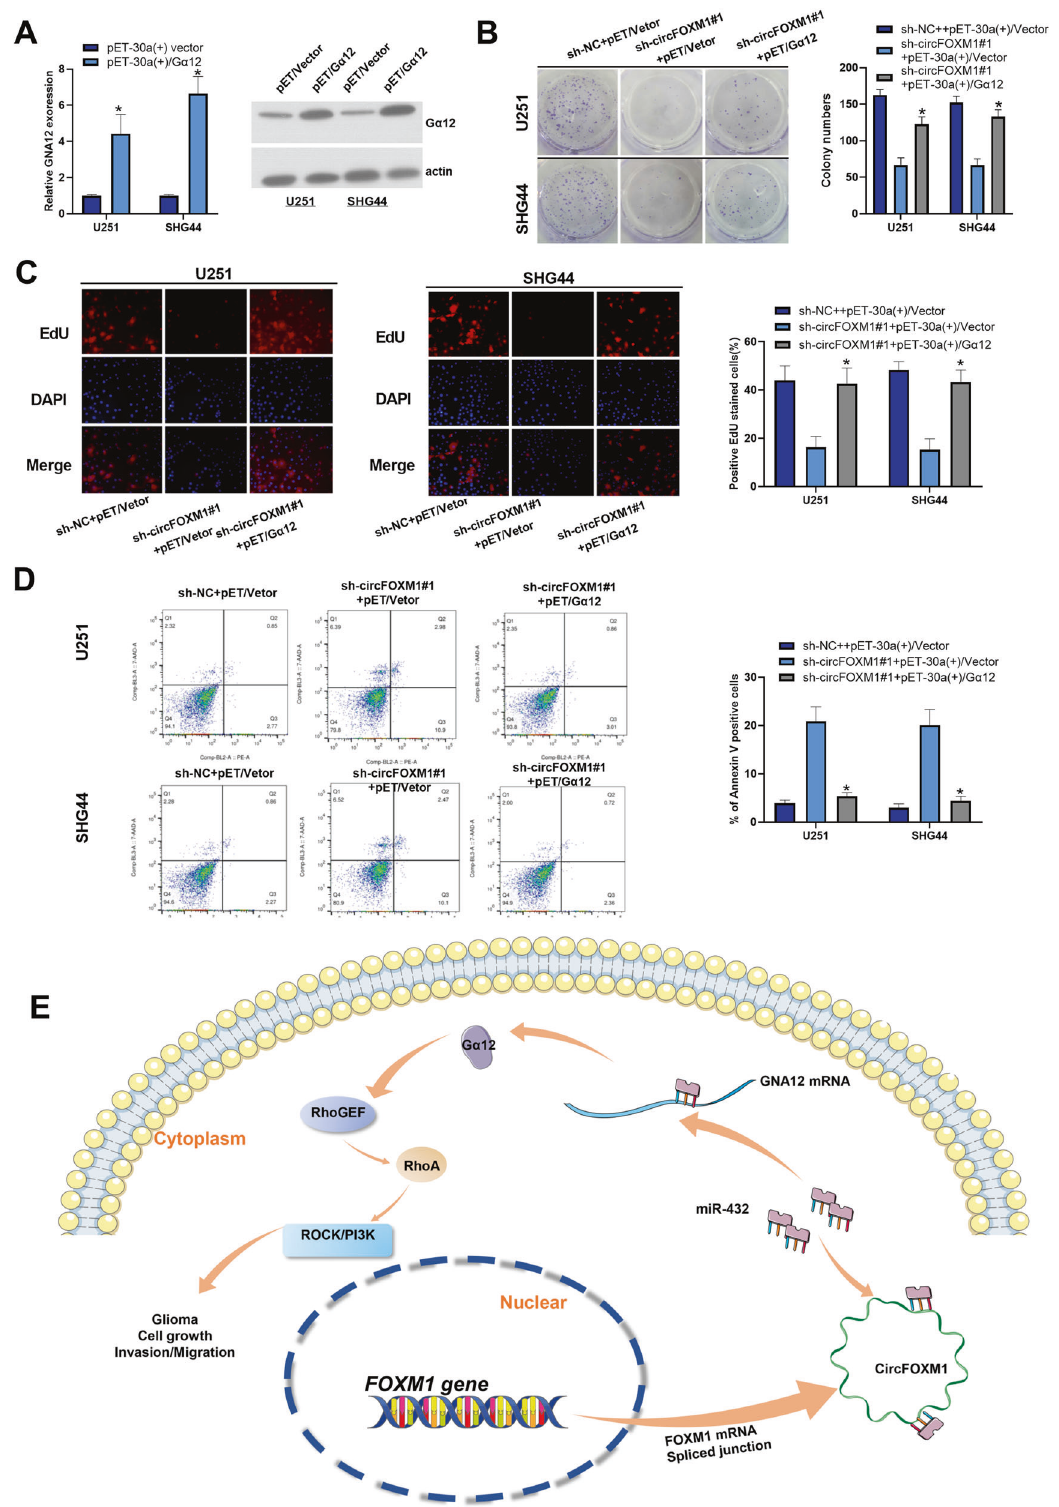
Fig. 7 circFOXM1 promotes the tumorigenesis of glioma cells via G α 12. A Expression of G α 12 in glioma cells in response to pET-30a ( + )/G α 12 transfection. B , C The proliferation of glioma cells was detected by colony-formation and EdU assays in response to circFOXM1 knockdown. D Apoptosis of glioma cells detected by fl ow cytometry analysis. E Schematic illustration of the proposed mechanism of CircFOXM1 in glioma (* P <